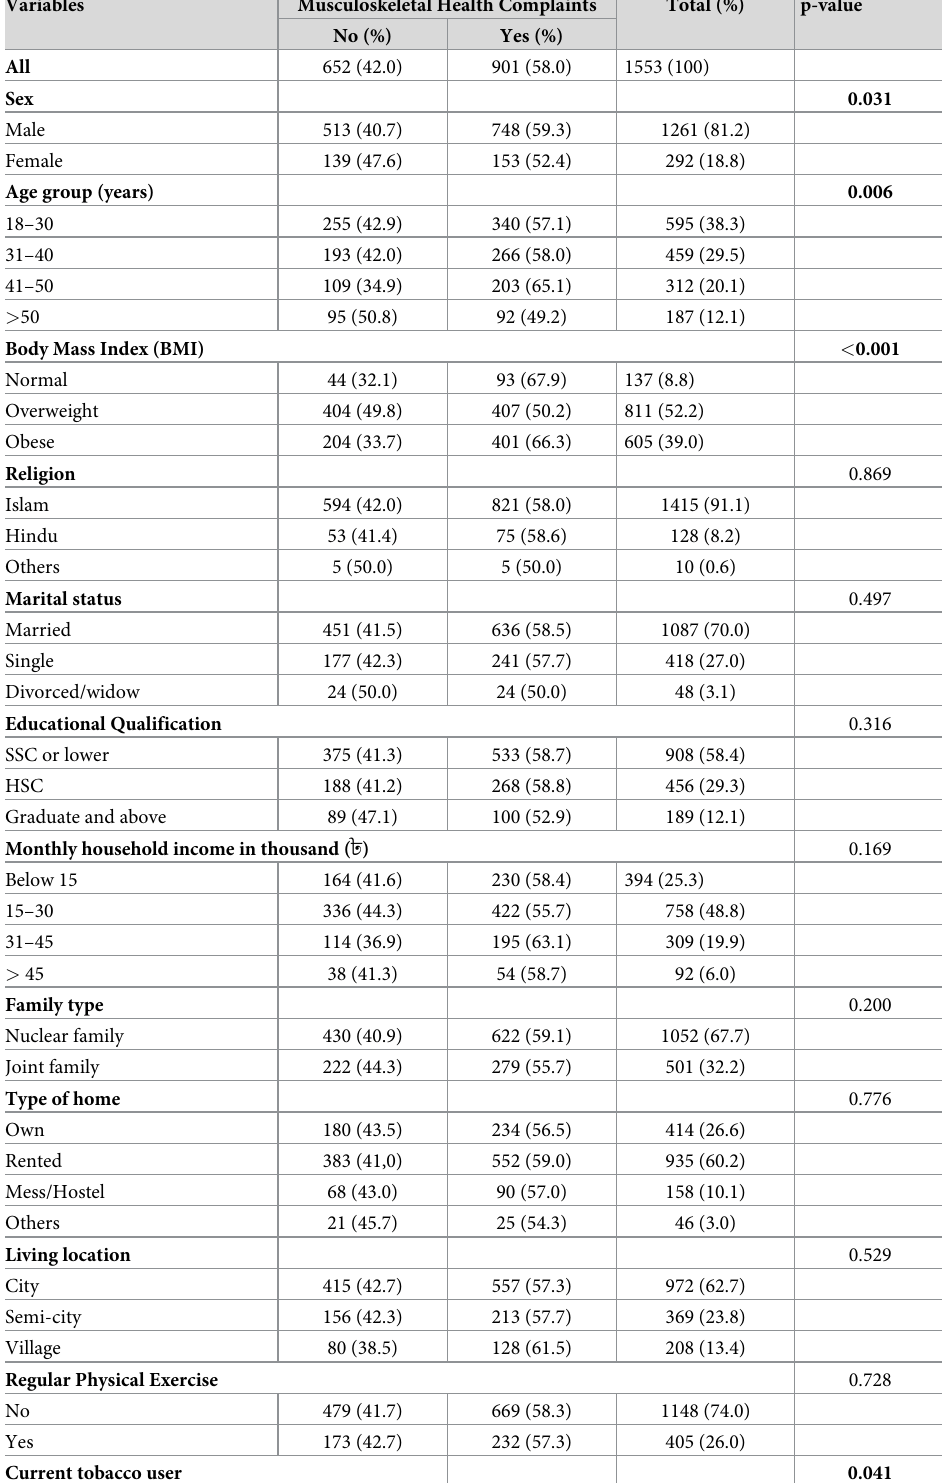
Table 1. Descriptive analysis: Sociodemographic, behavioral, and clinical factors and